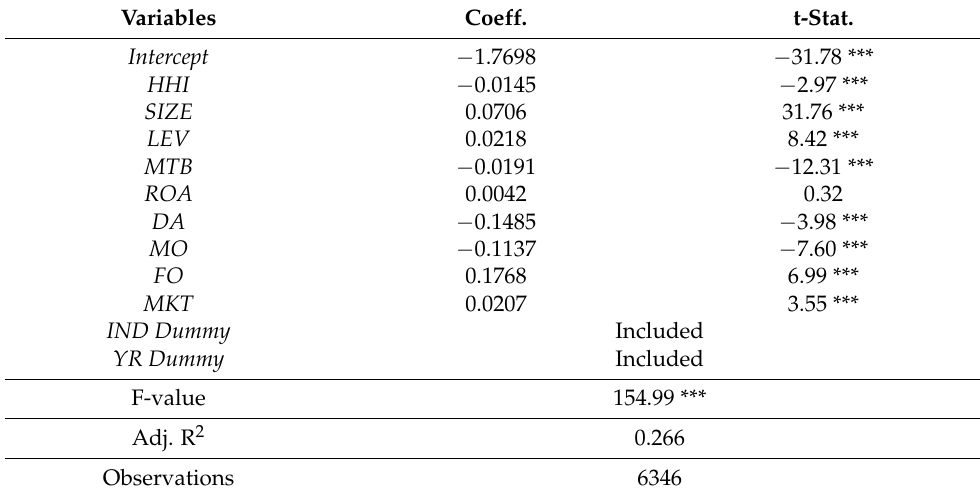
Table 4. The regression result of Hypothesis